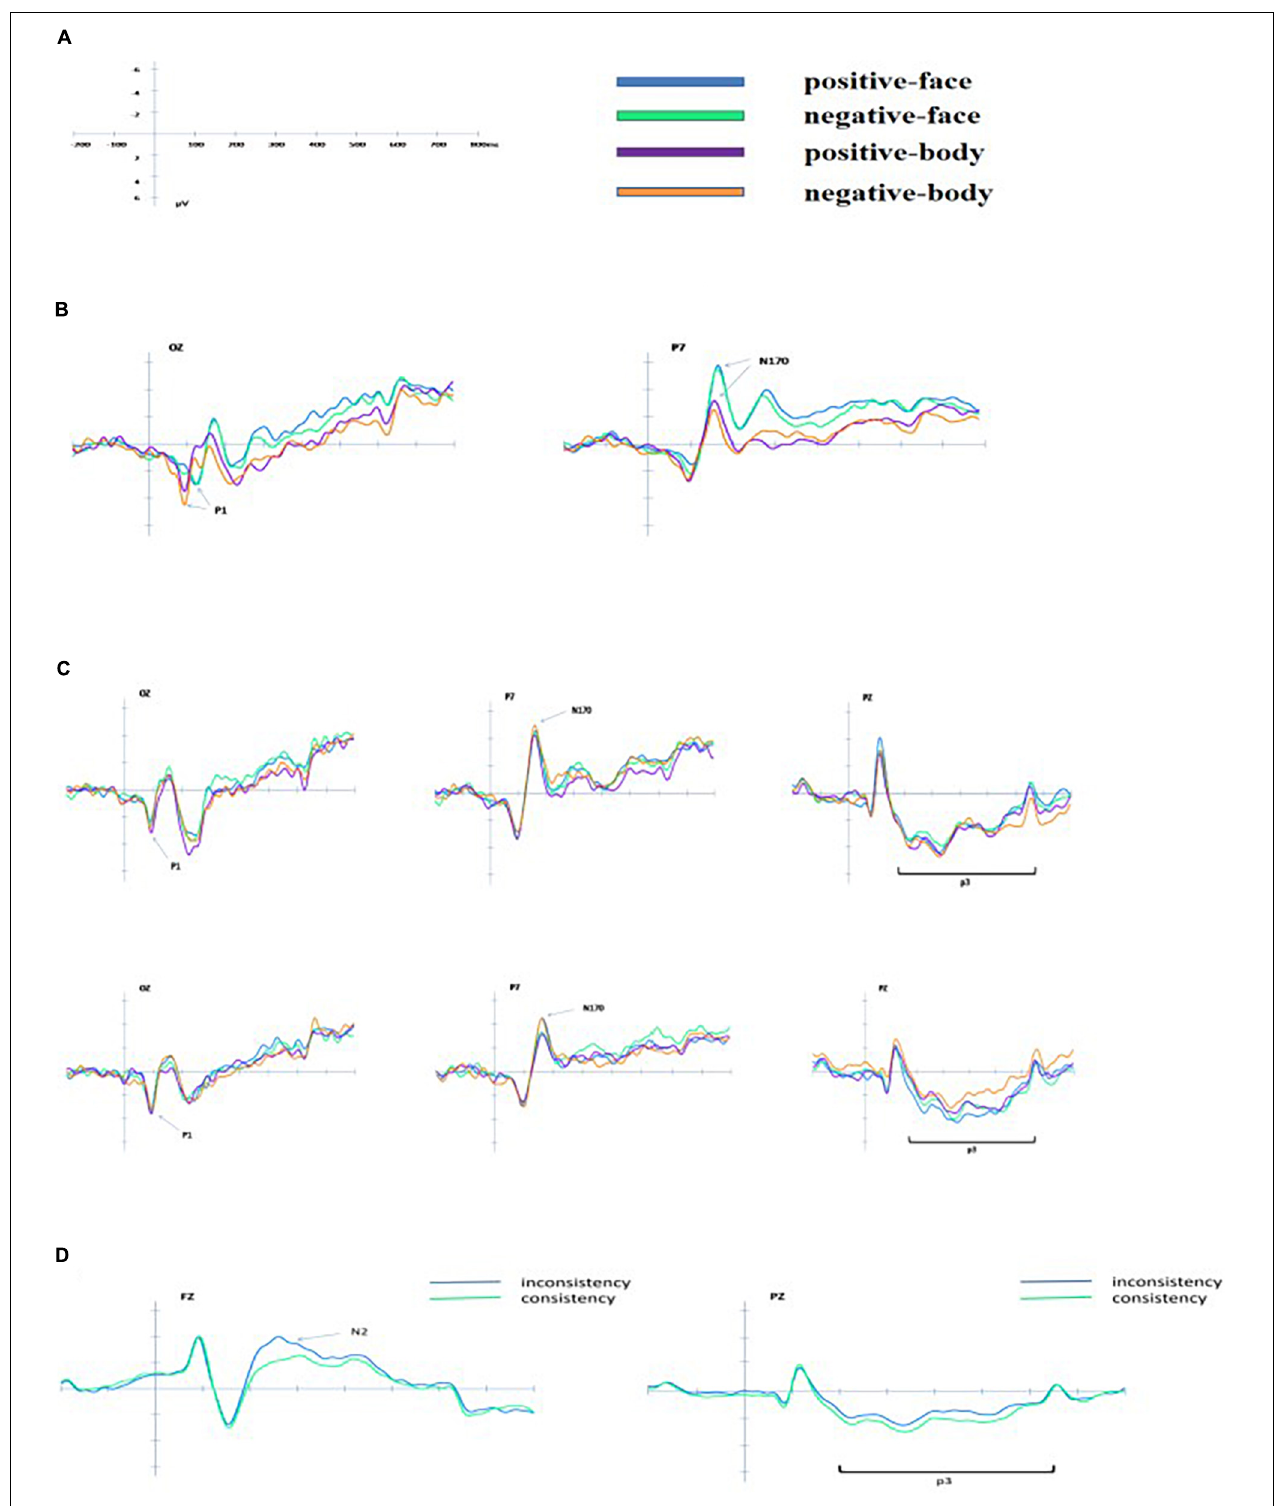
FIGURE 3 | The grand average ERPs for each condition. (A) Schematic diagram of the scale legend. (B) Group average waveforms of electrode for isolated positive-face, negative-face, and positive-body, negative-body on OZ and P7 (only partial electrode points are shown). (C) Group average waveforms of electrode for compound facial and bodily expressions on OZ, P7, and PZ (upper: judging the face; bottom: judging the body). (D) Group average waveforms of the electrode for compound facial and bodily expressions (consistency and inconsistency) on FZ and PZ (left: N2 on FZ; right: P3 on PZ).